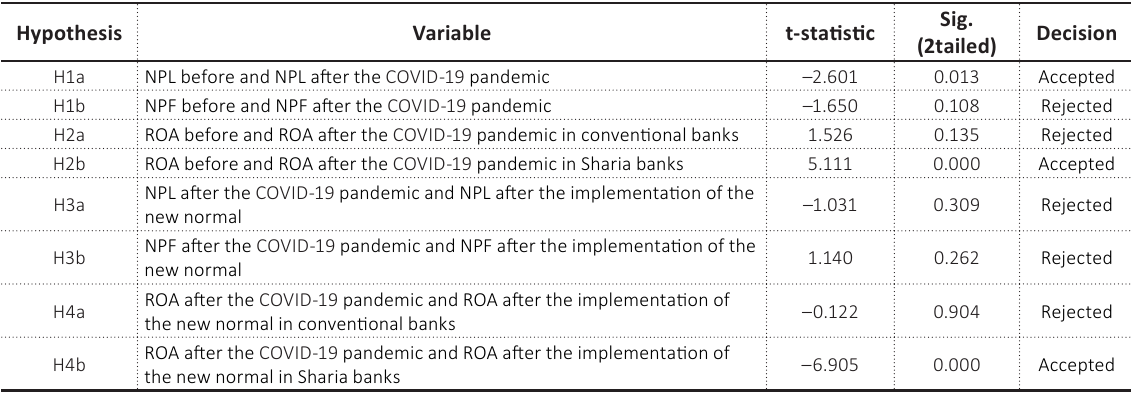
Table 1. Hypothesis testing